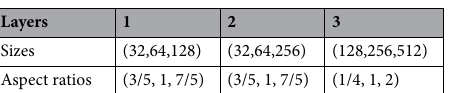
Table 1. Parameter settings of the RPN anchor points.